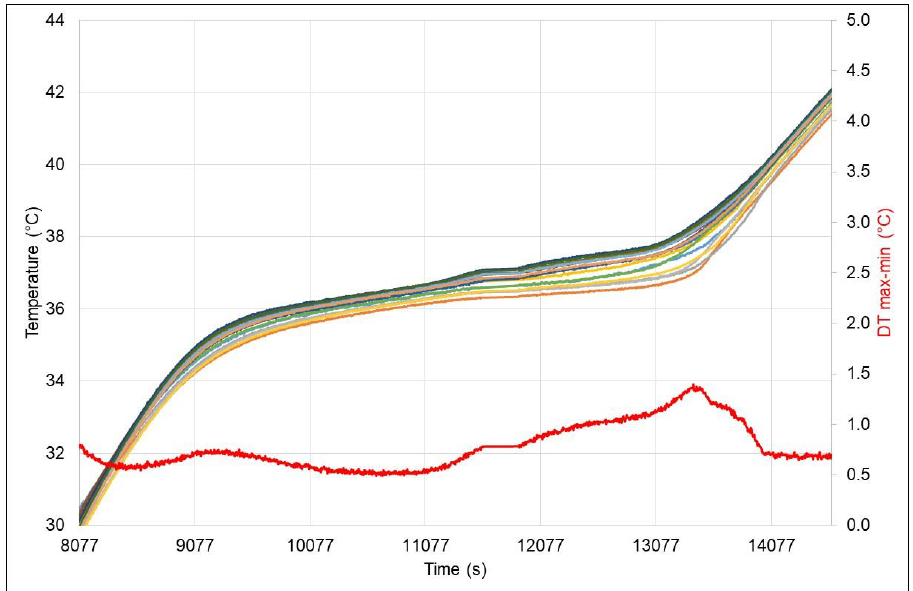
Figure 14. Wall temperature of the cells during an experimental run with a thermal dissipation of P = 0.55 W per cell.